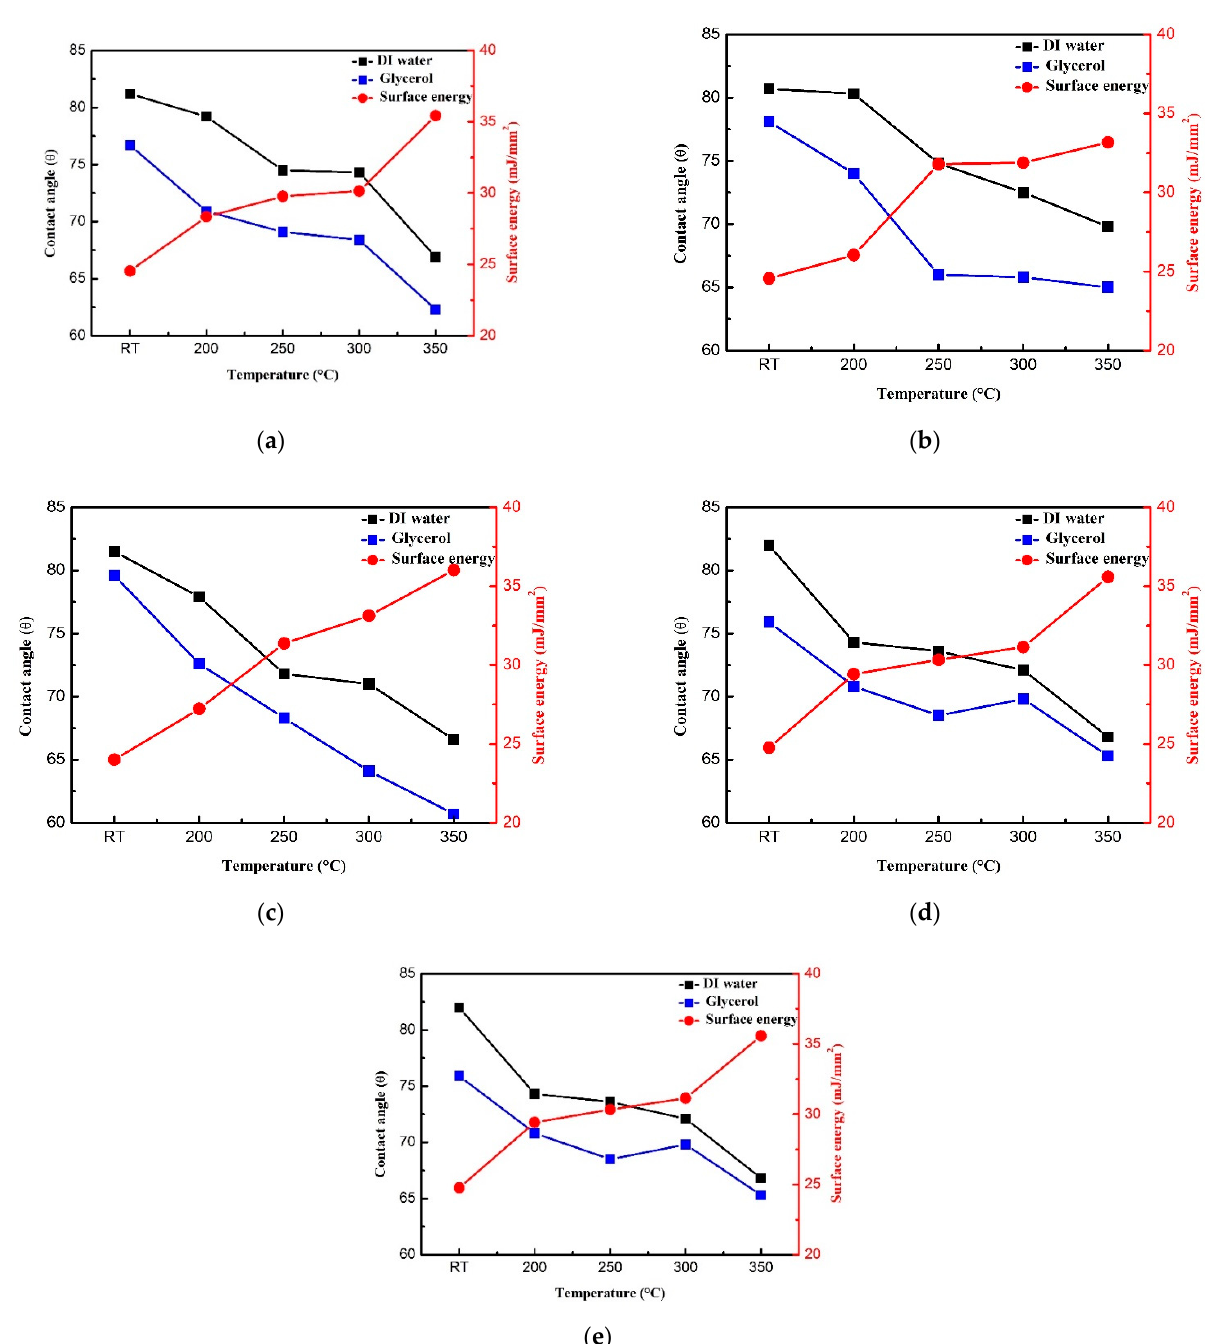
Figure 5. The relationship between contact angle, surface energy, and post-annealing temperature. ( a ) 10 nm, ( b ) 20 nm, ( c ) 30 nm, ( d ) 40 nm, ( e ) 50 nm.